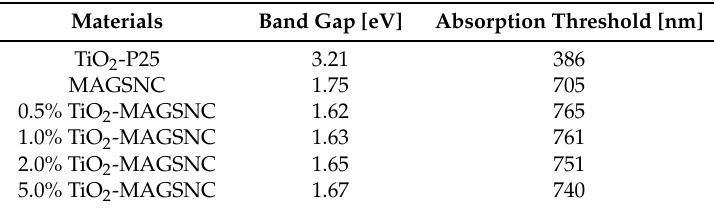
Table 1. Optical properties of synthesized TiO 2 -MAGSNC photocatalysts. P25: pure commercial TiO 2 from Evonik Industries.